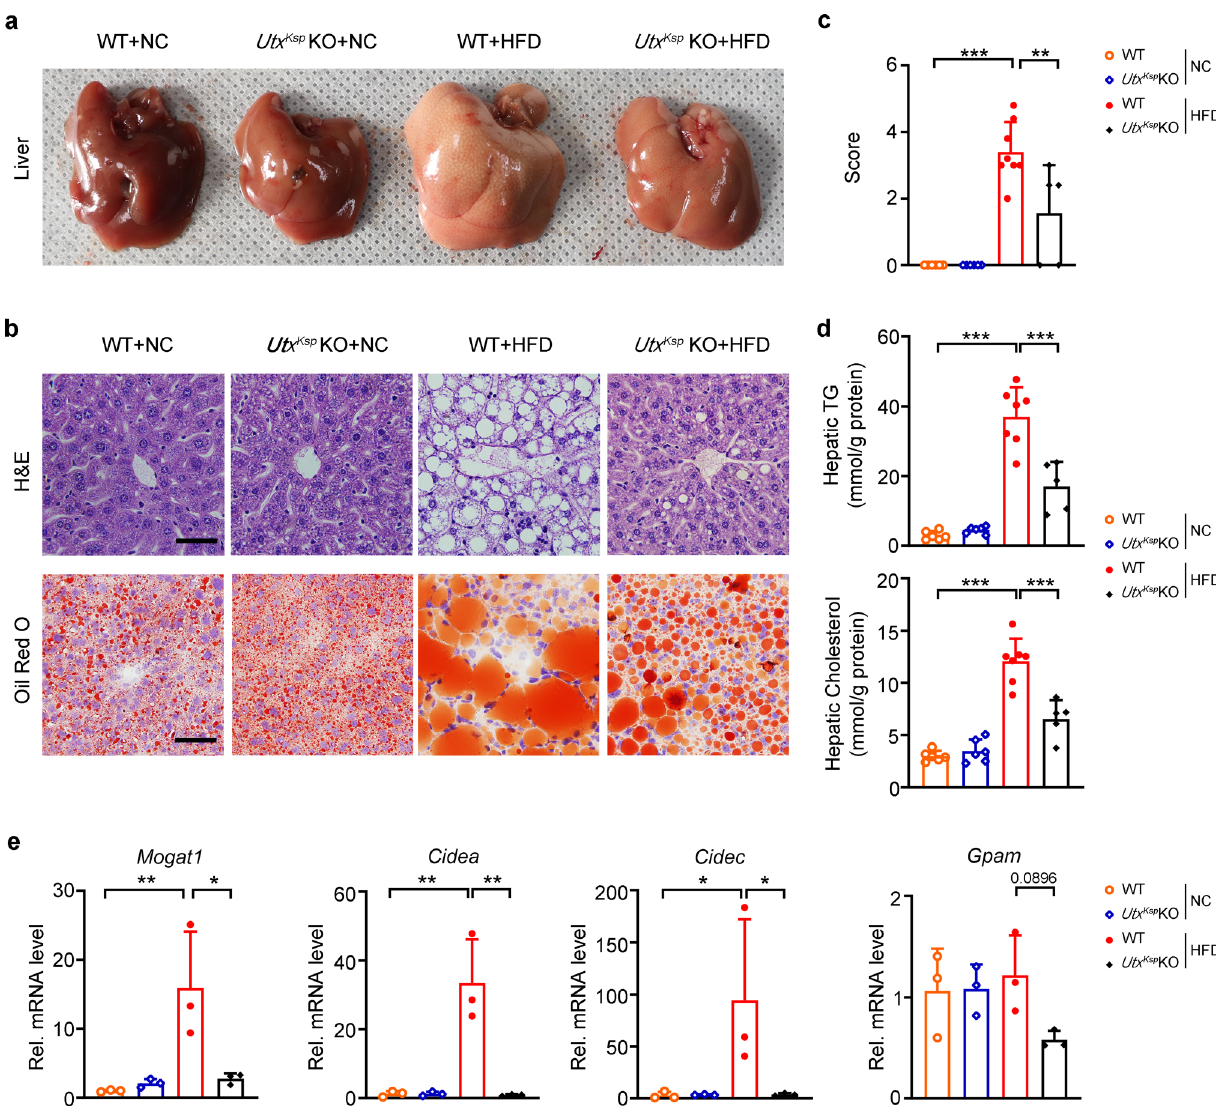
Fig. 3 Reduced hepatic lipid accumulation and steatosis in Utx Ksp KO mouse under HFD stress. a Representative images of dissected liver of indicated groups. b , c Representative images of H&E and Oil Red O staining ( b ), with quanti fi cation for relative liver steatosis score ( c ) of the indicated groups, n = 6, 6, 8, 5 independent animals for WT + NC or Utx Ksp KO + NC or WT + HFD or Utx Ksp KO + HFD group, respectively (mean ± SD). *** P (WT + NC vs WT + HFD) < 0.0001, ** P (WT + HFD vs Utx Ksp KO + HFD) = 0.002 (one-way ANONA). Scale bar, 50 μ m. d , e Hepatic TG (triglycerides) and cholesterol levels ( d ) and TG synthesis/lipid storage related gene levels ( e ) of indicated groups. d n = 6, 6, 7, 5 independent animals for WT + NC or Utx Ksp KO + NC or WT +